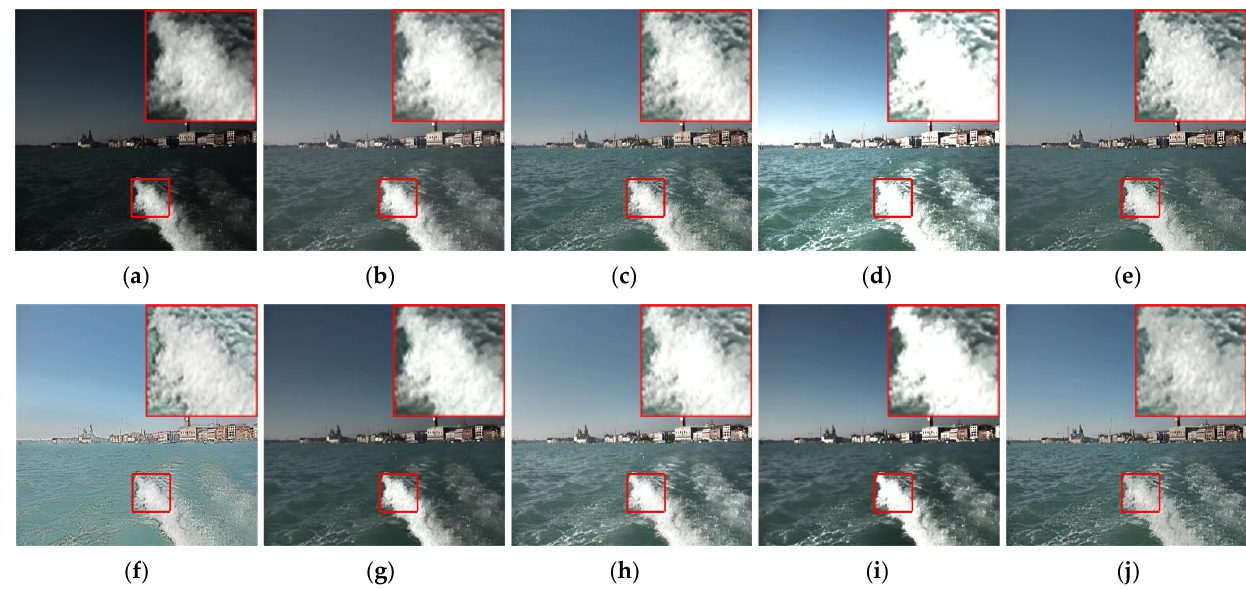
Figure 16. Enhanced results of “Girl” image. ( a ) Original image; ( b ) BIMEF; ( c ) MF; ( d ) LIME; ( e ) SR;